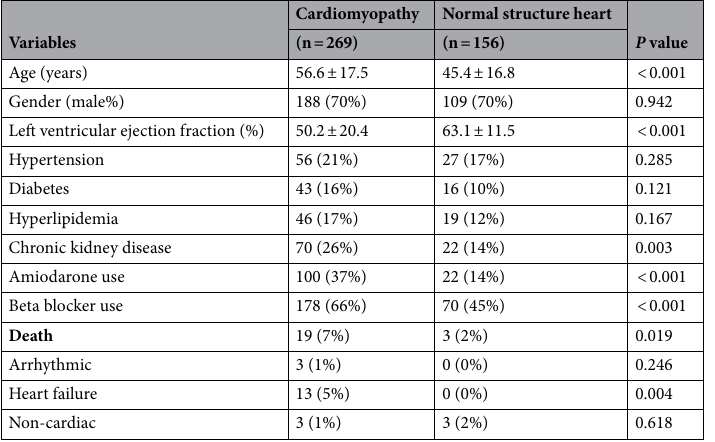
Table 3. Comparisons of clinical characteristics of patients with cardiomyopathy and normal structure heart patients in the SADS group during follow-up. SADS sudden arrhythmic death syndrome.